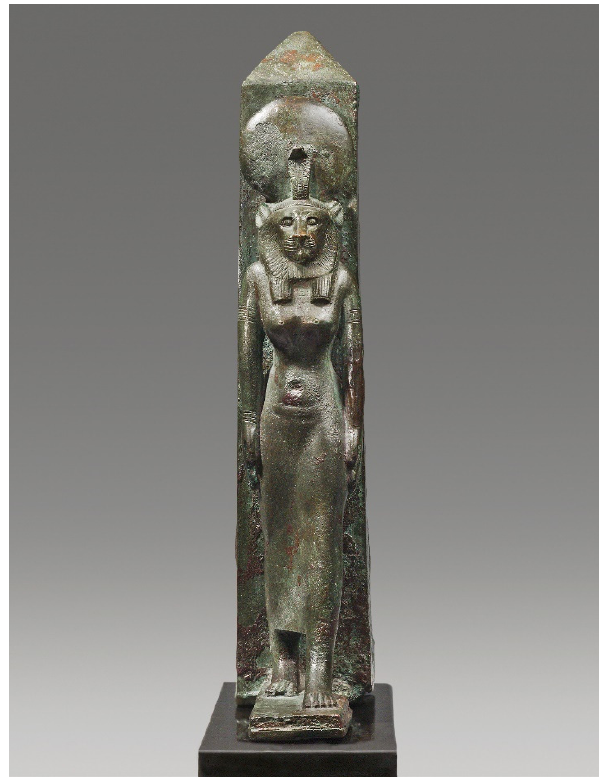
Figure 1. A bronze reliquary for an ichneumon dedicated to the Egyptian goddess Wadjet, front view. (Private collection, courtesy of the owner).